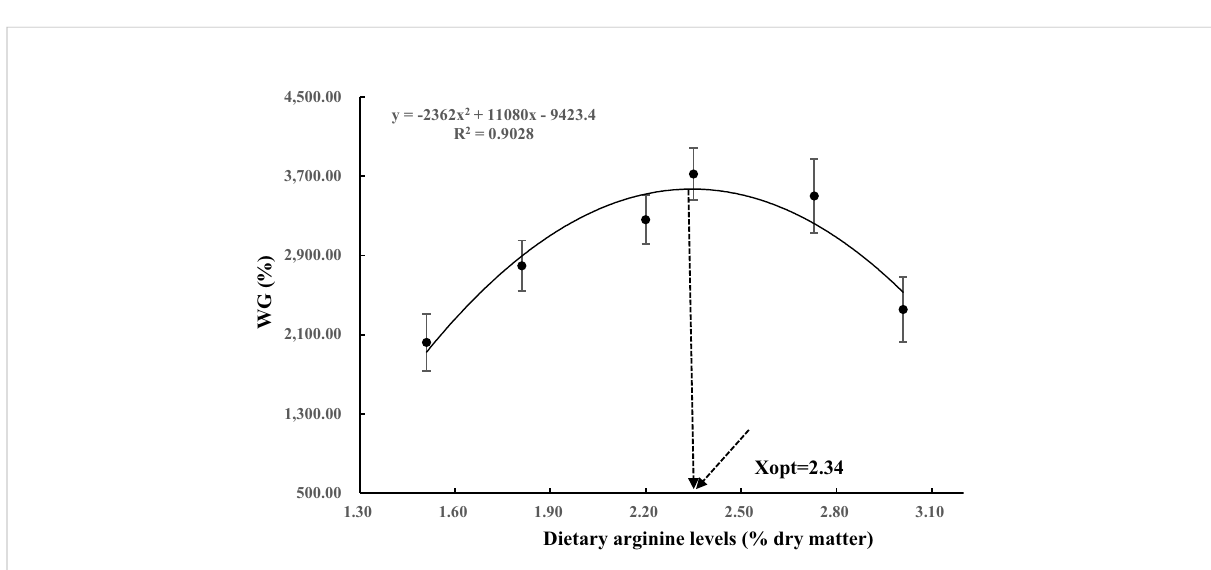
FIGURE 1 Relationship between the weight gain (WG, %) with the dietary arginine levels, where Xopt represents the optimal dietary Arg level for the maximum WG.